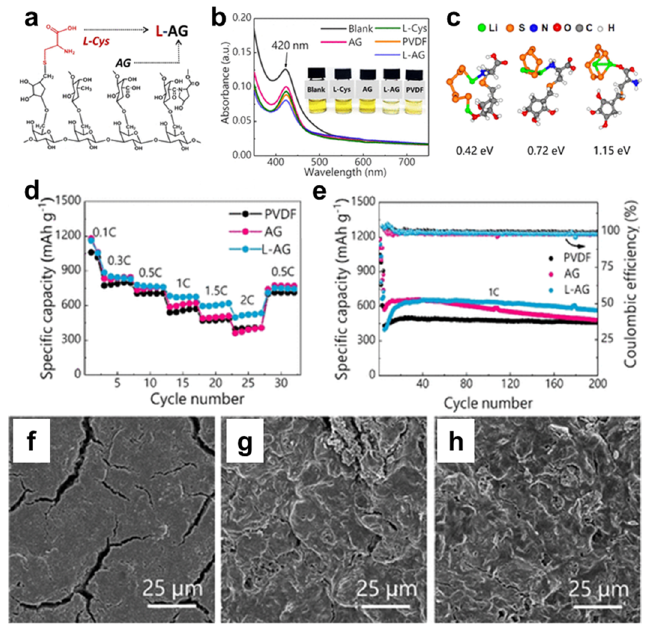
Figure 5. ( a ) Chemical structure of modified AG (L-AG). ( b ) Photographs of the Li 2 S 6 adsorption by different materials, including L-AG. ( c ) Geometries and simulated binding energies of Li 2 S 6 on the –NH 2 and –COOH groups in L-AG. Comparison of electrochemical performance in terms of ( d ) cycle retention characteristics and ( e ) rate capabilities for electrode with different binders (PVdF, AG, and L-AG). Ex situ SEM images of electrode with ( f ) PVdF, ( g ) AG, and ( h ) L-AG after cycling [64].